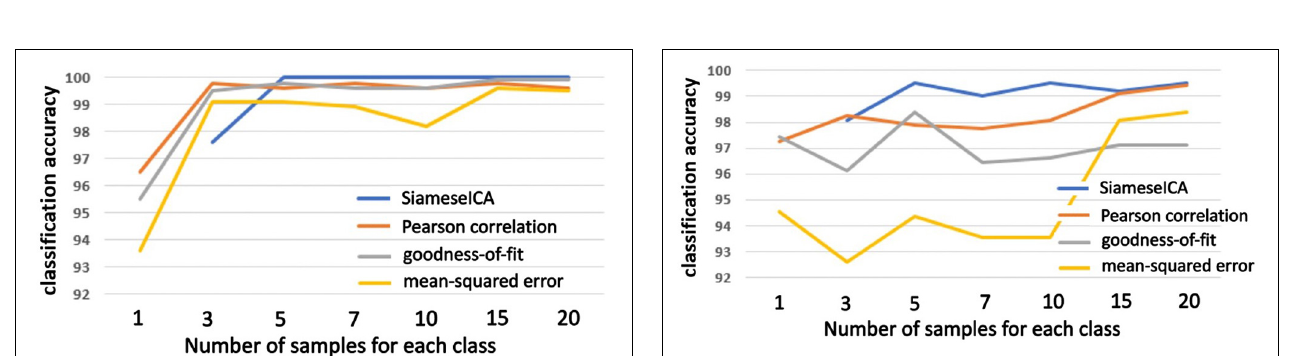
FIGURE 6 | Plots of the embedding vectors projected down to 2-dimensions using PCA before and after the training with different numbers of training samples ( N = 2, 3, 4, 5, 10, and 20). With each color representing a distinct class of the RSNs as shown by the legend.